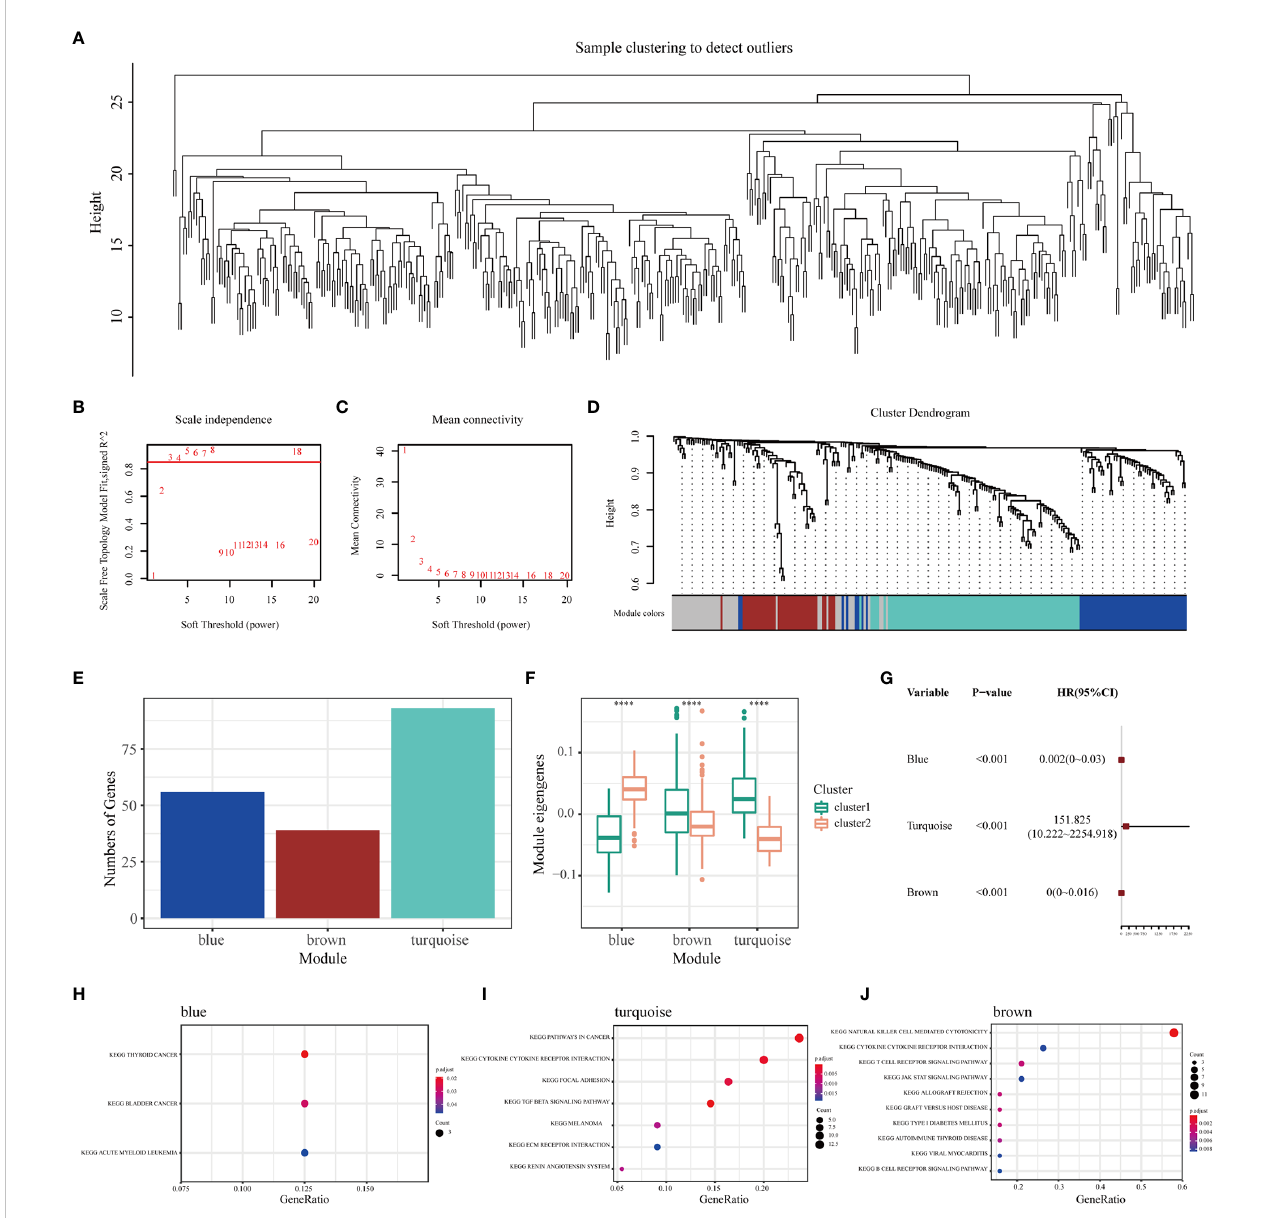
FIGURE 7 Identi fi cation of immune gene co-expression modules and hub genes of BLCA. (A) Sample clustering. (B) Scale-free fi t index and (C) mean connectivity for various soft-thresholding powers. (D) Dendrogram of immune genes clustered based on the average-linkage hierarchy clustering method. (E) The number of genes in each module. (F) Differential distribution of MEs of each module in BLCA immune clusters. (G) Prognostic analysis of the blue, turquoise and brown modules. The top KEGG terms enriched in the (H) blue, (I) turquoise and (J) brown modules. ****P <